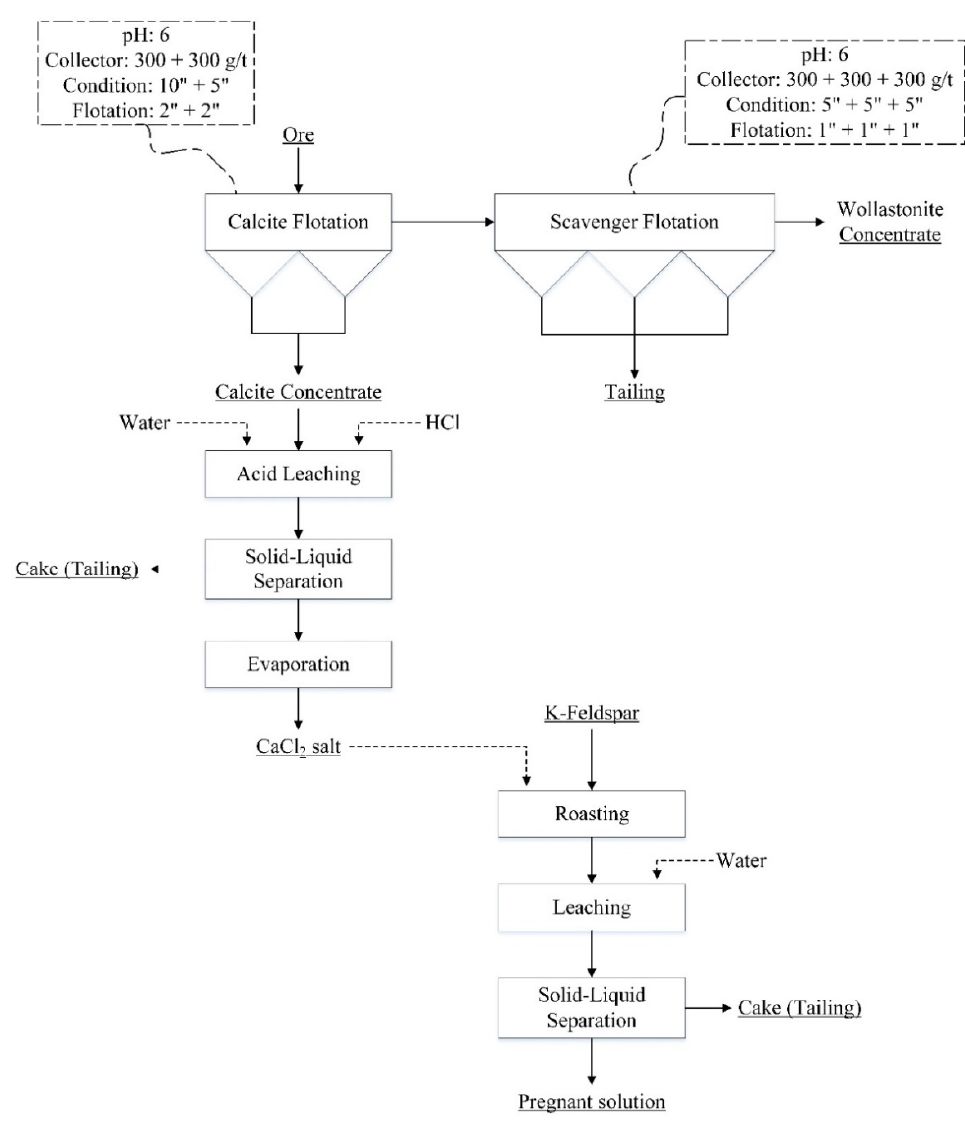
Figure 7. General flowchart of the chemical processing following flotation.